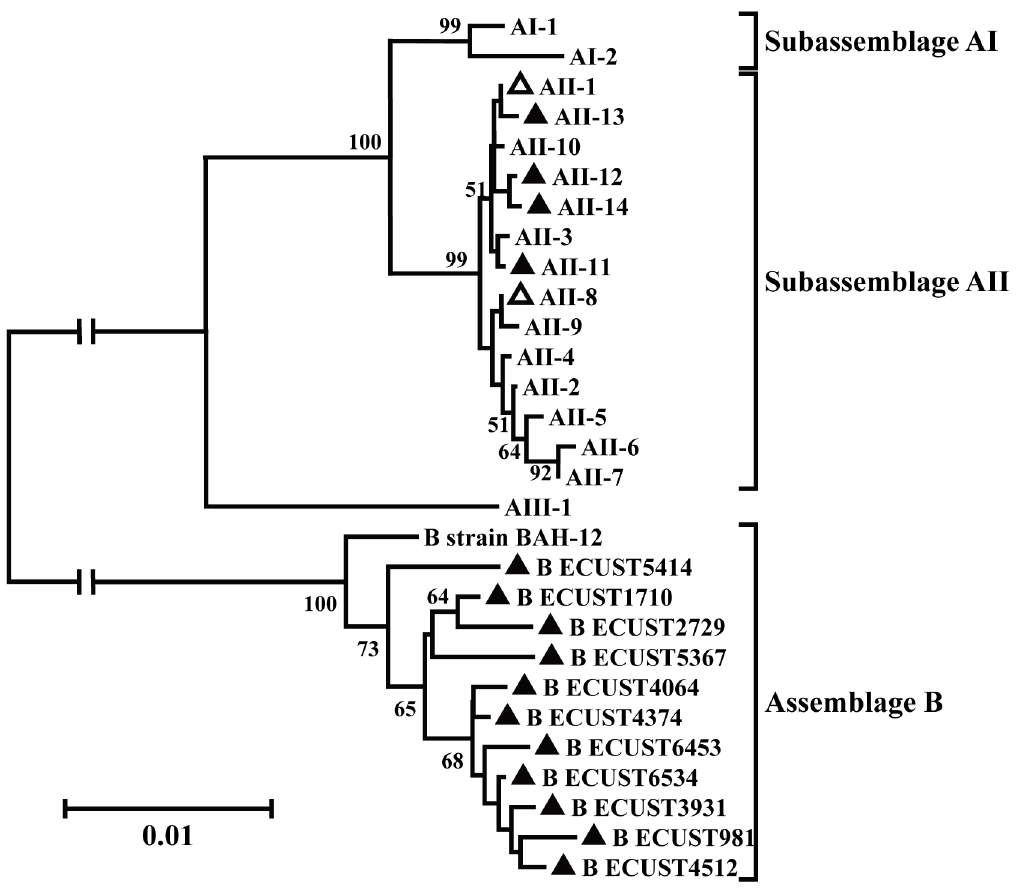
Figure 2. Phylogenetic relationship of multilocus sequence subtypes of Giardiaduodenalis . Sequences from this and a previous study [22] are included in the analysis. The relationship of multilocus sequence subtypes was inferred by a neighbor-joining analysis of concatenated sequences of the gdh , tpi , and bg fragments, based on the p-distance model. Bootstrap values . 50% are shown. Novel and known genotypes identified in this study are indicated by black and white triangles, respectively.